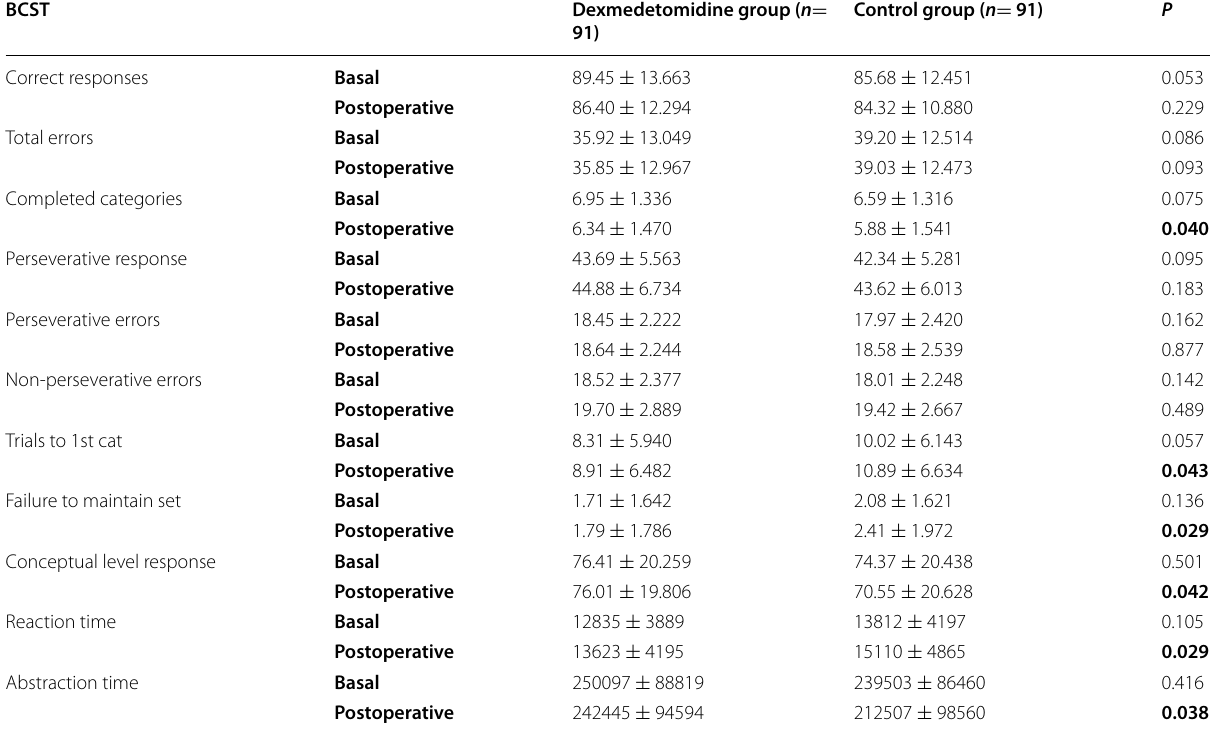
Table 4 Pre‑and postoperative Berg’s “Wisconsin” Card Sorting Test (BCST) assessment in the studied